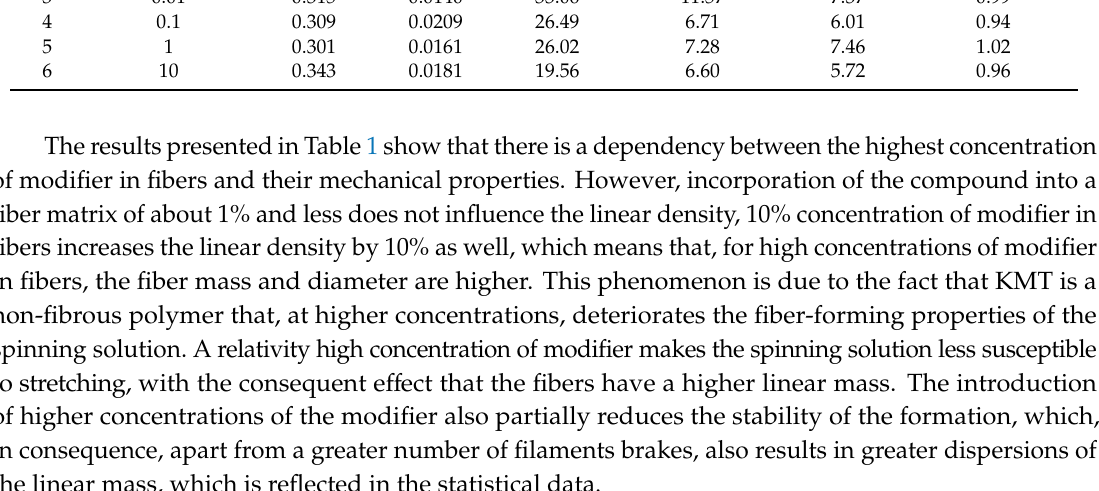
Standard Elongation Deviation for at Break Elongation at (%) Break